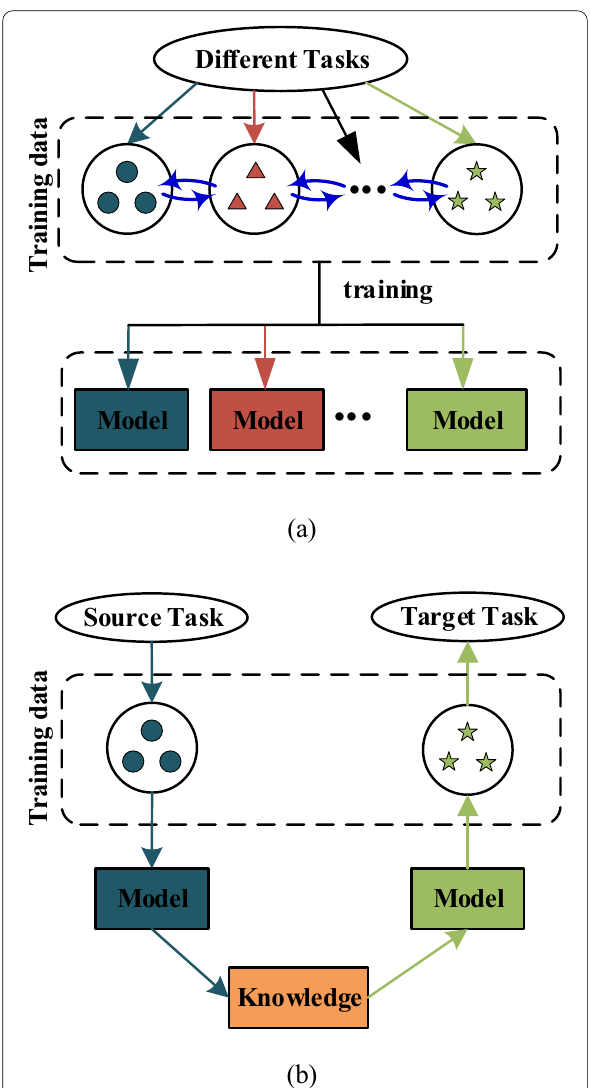
Figure 1 Comparison of multitask learning (MTL) and transfer learning (TL): a MTL; b